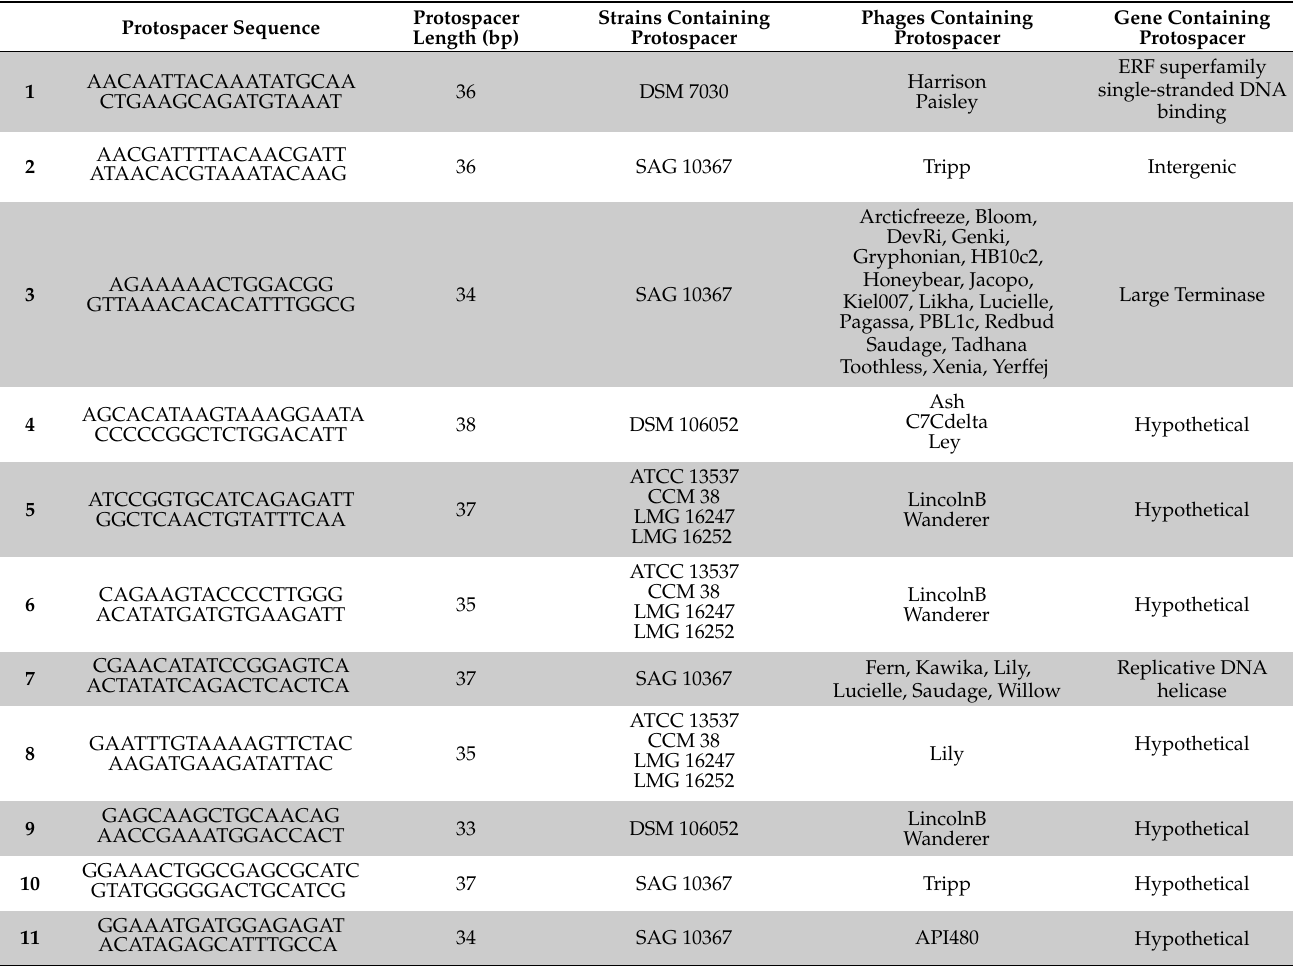
Table 4. Complete list of the 18 unique protospacer sequences found in P. larvae strains and phages. Protospacer Sequence Protospacer Length (bp) Strains Containing Protospacer Phages Containing